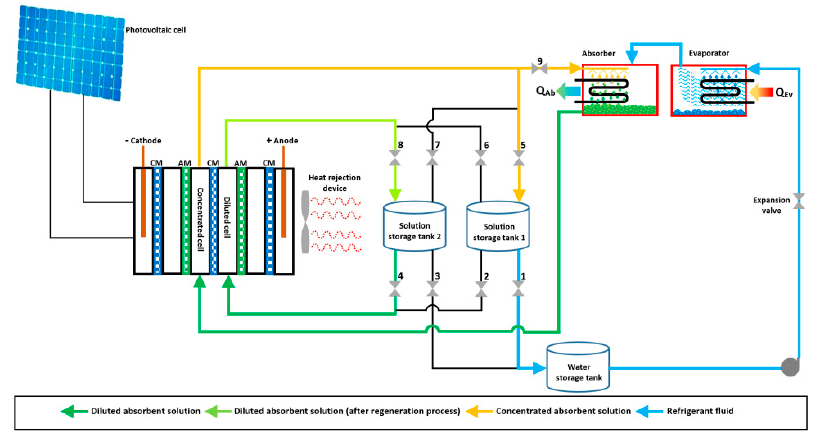
Figure 8. Schematic diagram of the system proposed by Li and Zhang [78].